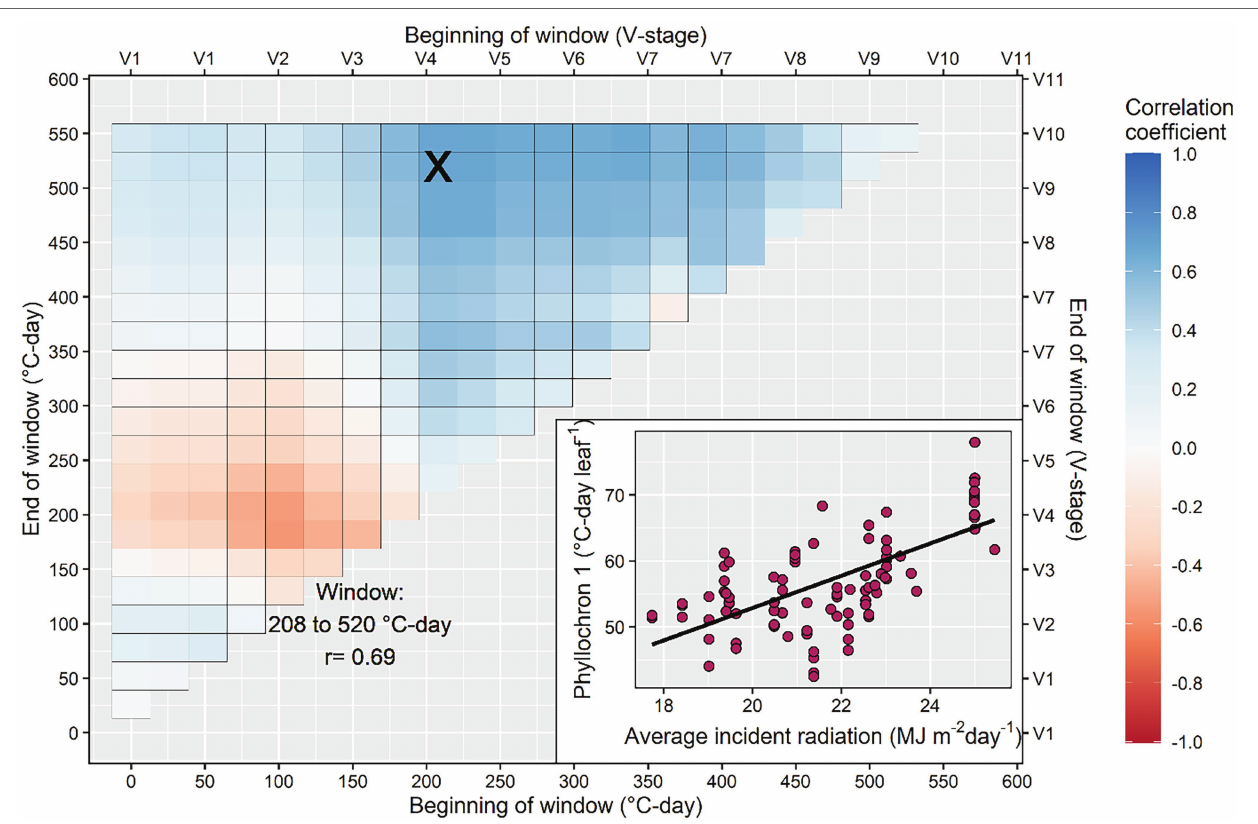
FIGURE 5 | Search process to identify the critical window during the growing season in which average incident radiation determines the rate of leaf appearance. The inset figure shows in detail the strongest relationship between phyllochron and average incident radiation calculated in the interval between 208 and 520 ° C-day. This interval corresponds to the period between the 4th and the 10th collared leaf, approximately.